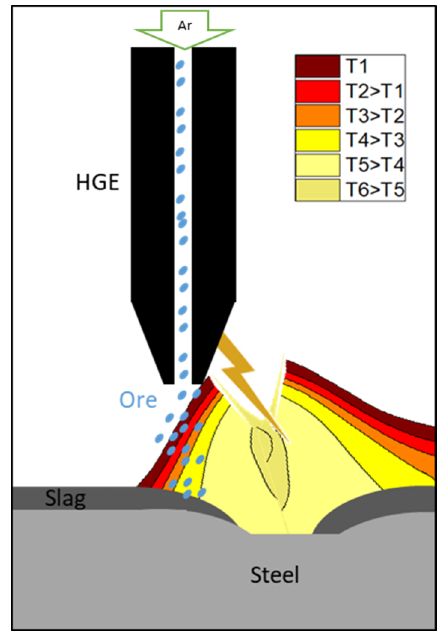
Figure 5. Schematic visualization of the effects of the arc shift between the hollow graphite electrode (HGE) and the steel bath on the thermal profile in hydrogen plasma smelting reduction (HPSR) processes.